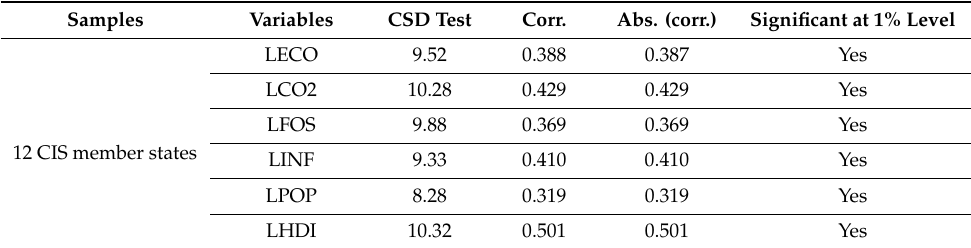
Table 2. Cross-section dependence test